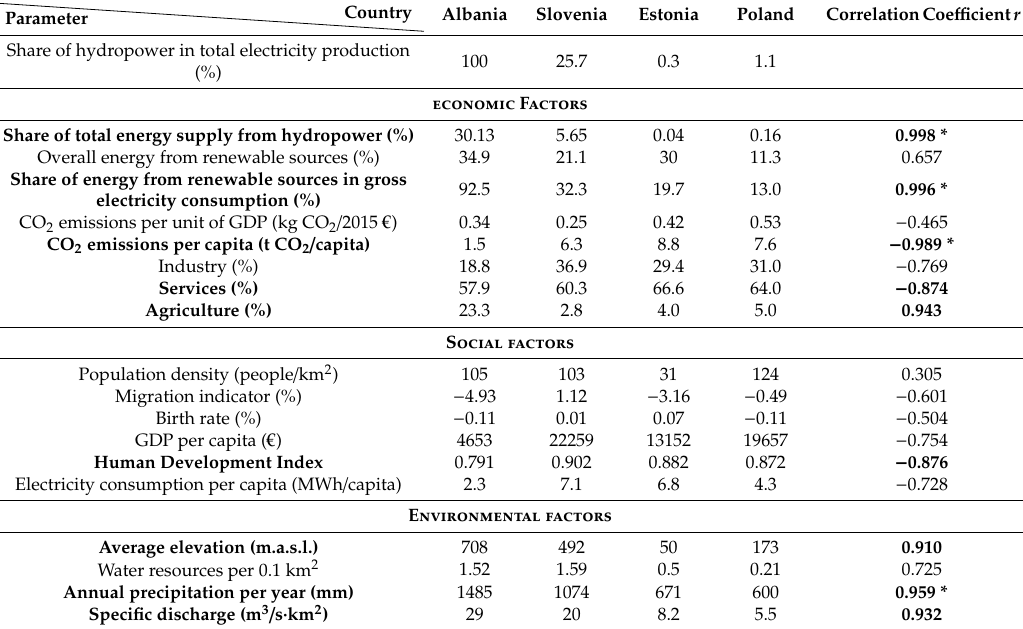
Table 1. Analysis of the relationship between the share of hydropower in the total electricity production and selected social, economic, and environmental factors [2,3,31,35,44,80–88]. Parameter Country Albania Slovenia Estonia Poland CorrelationCoe ffi cient r Share of hydropower in total electricity production (%) economic F actors Share of total energy supply from hydropower